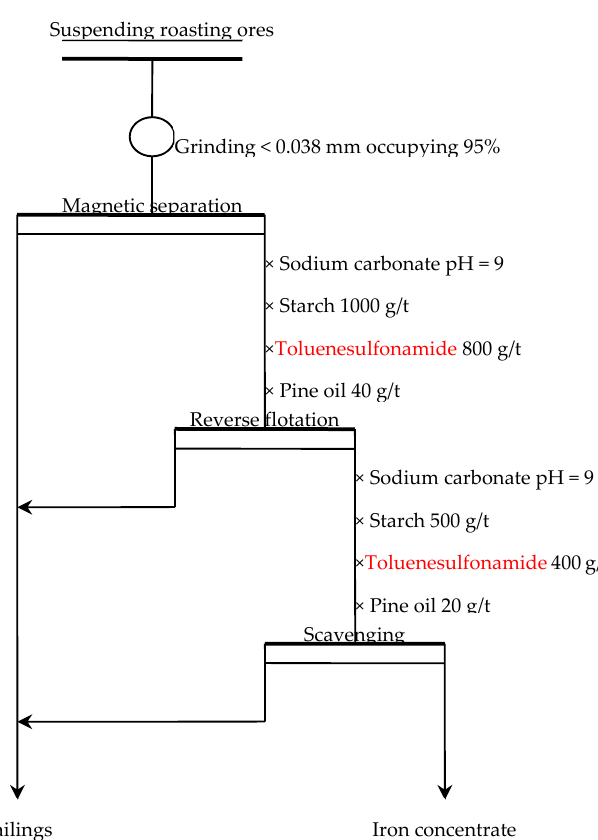
Figure 9. Combined test flowsheet for low-intensity magnetic separation–reverse flotation process. Table 4. Test results for low-intensity magnetic separation–reverse flotation process (%).